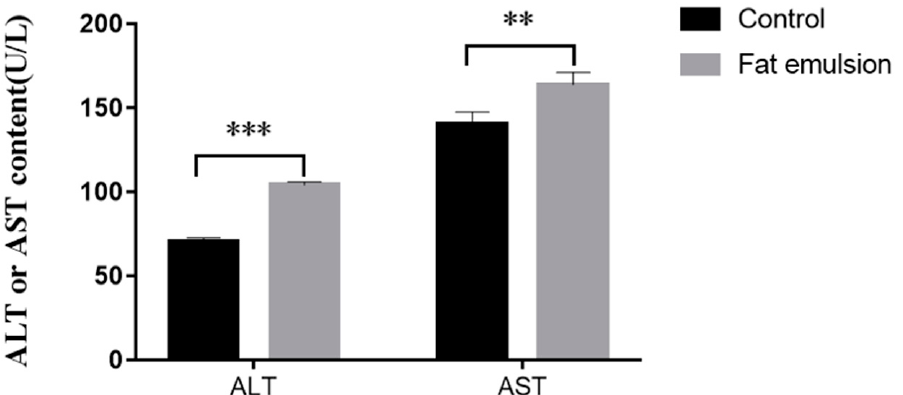
Figure 3. Effect of fat emulsion on the concentration of ALT and AST in the culture medium of hepatocytes. Note: Data are presented as mean ± SEM. ** p < 0.01, *** p < 0.001; statistical differences were assessed by one-way ANOVA with subsequent Tukey’s HSD test.